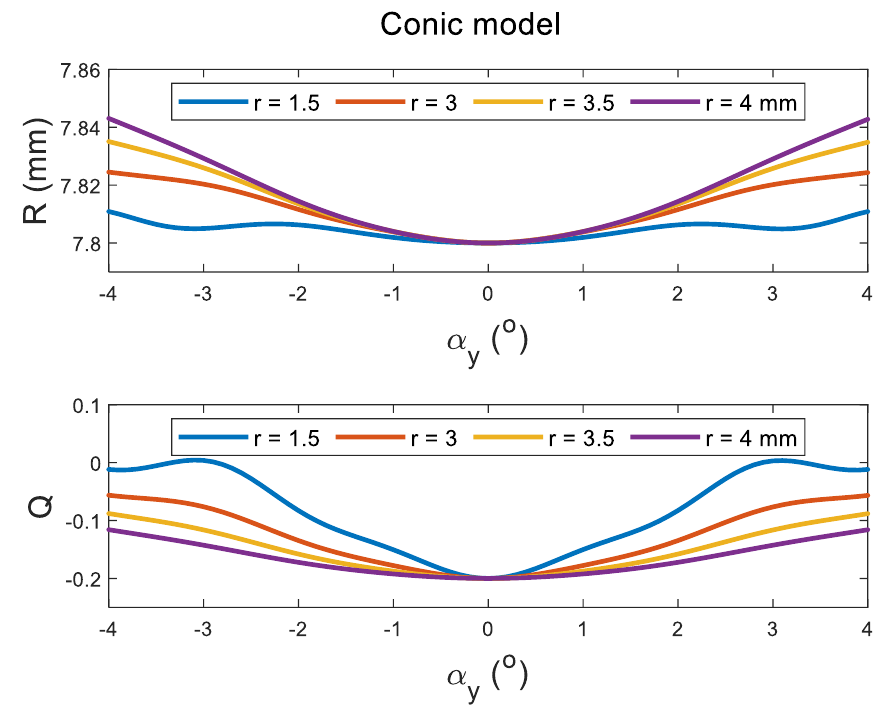
Figure 2. Effect of tilting a simulated conic surface of nominal apical radius of 7.8 mm and nominal asphericity of − 0.2 on its radius and asphericity as fitted in tilted positions at different aperture sizes. Tilt has been introduced by rotating the surface around the Y-axis, then shifting the apex to the origin position.